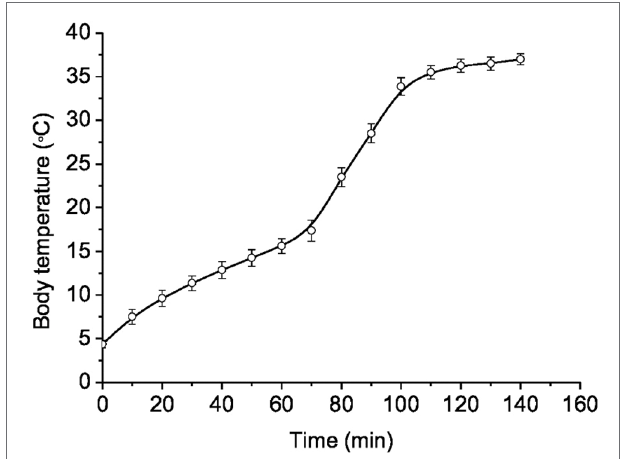
FIGURE 2 | Dynamics of body temperature recovery during arousal from hibernation (Tb ~ 4 ° C) in ground squirrels transferred to a room with a temperature of 25 ° C ( n = 12). Abscissa – heating time (min); ordinate – body temperature ( ° C). Data are presented as mean ± SEM.